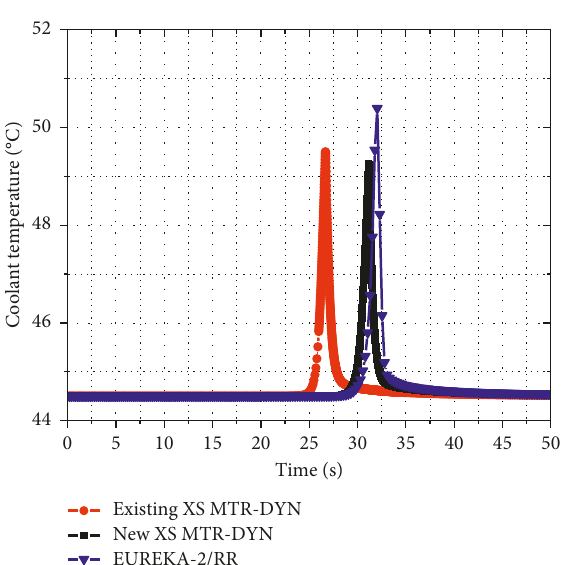
Figure 8: Reactivity inserted for RIA transient analysis within start-up range.